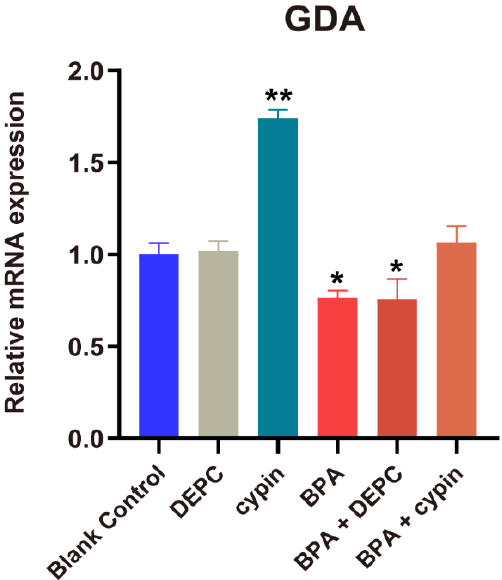
Figure 8. Expression of cypin gene after microinjection of cypin mRNA in zebrafish embryos. Data are the mean ± SD, *, significant from blank control, p < 0.05. **, significant from blank control, p < 0.01. DEPC group: microinjection of DEPC water; cypin group; microinjection of cypin mRNA; BPA treatment group: BPA treatment; BPA + DEPC group: BPA treatment after microinjection of DPEC; BPA + cypin group: BPA treatment after microinjection of cypin